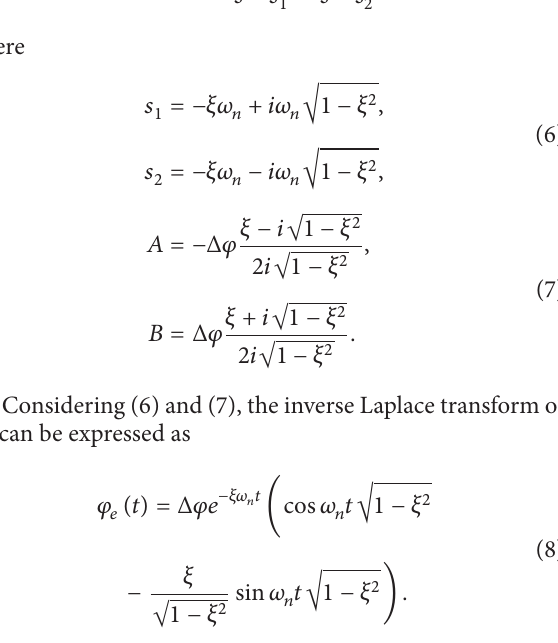
Detector. In Figure 3, the loop parameters of three PLLs are = 1, 4, 10 and 𝜉 = √2/2 and the amplitude of phase 𝜔 𝑛 jumping is equal to 1/10 8 period of reference signal.